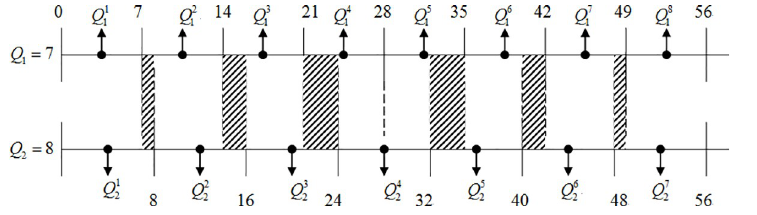
Fig 8. Quantization of mod(Q 2 /Q 1 ) in pixel